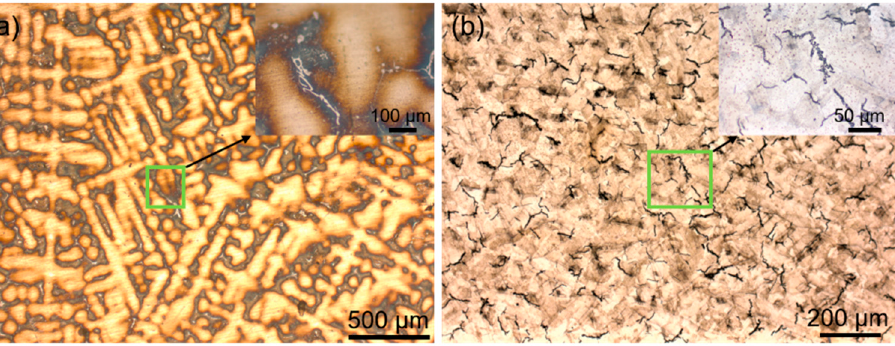
Figure 2. Optical microstructure images of K213 alloy. ( a ) As-cast, ( b ) SLM.